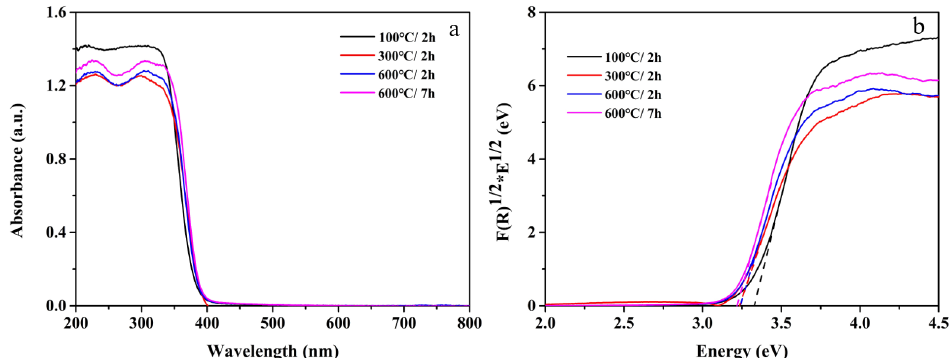
Figure 6. ( a ) UV-vis absorption spectra of four samples and ( b ) tauc plot. Note: 100 °C/2 h, the precursor calcined at 100 °C for 2 h; 300 °C/2 h, the precursor calcined at 300 °C for 2 h; 600 °C/2 h, the precursor calcined 600 °C for 2 h; 600 °C/7 h, the precursor calcined 600 °C for 7 h. Samples with different morphologies have different specific surface areas and pore tion isotherms and pore size distribution curves are shown in Figure 7a. The isotherms of was shown that the samples had a mesoporous structure and pore diameters between 2 Table 2. It can be seen that 600 °C/7 h had a larger specific surface area and pore volume than other samples, which was mainly caused by its hollow morphology. The higher specific surface area can reduce the diffusion resistance and provide more active sites to for pollutants is improved [35].